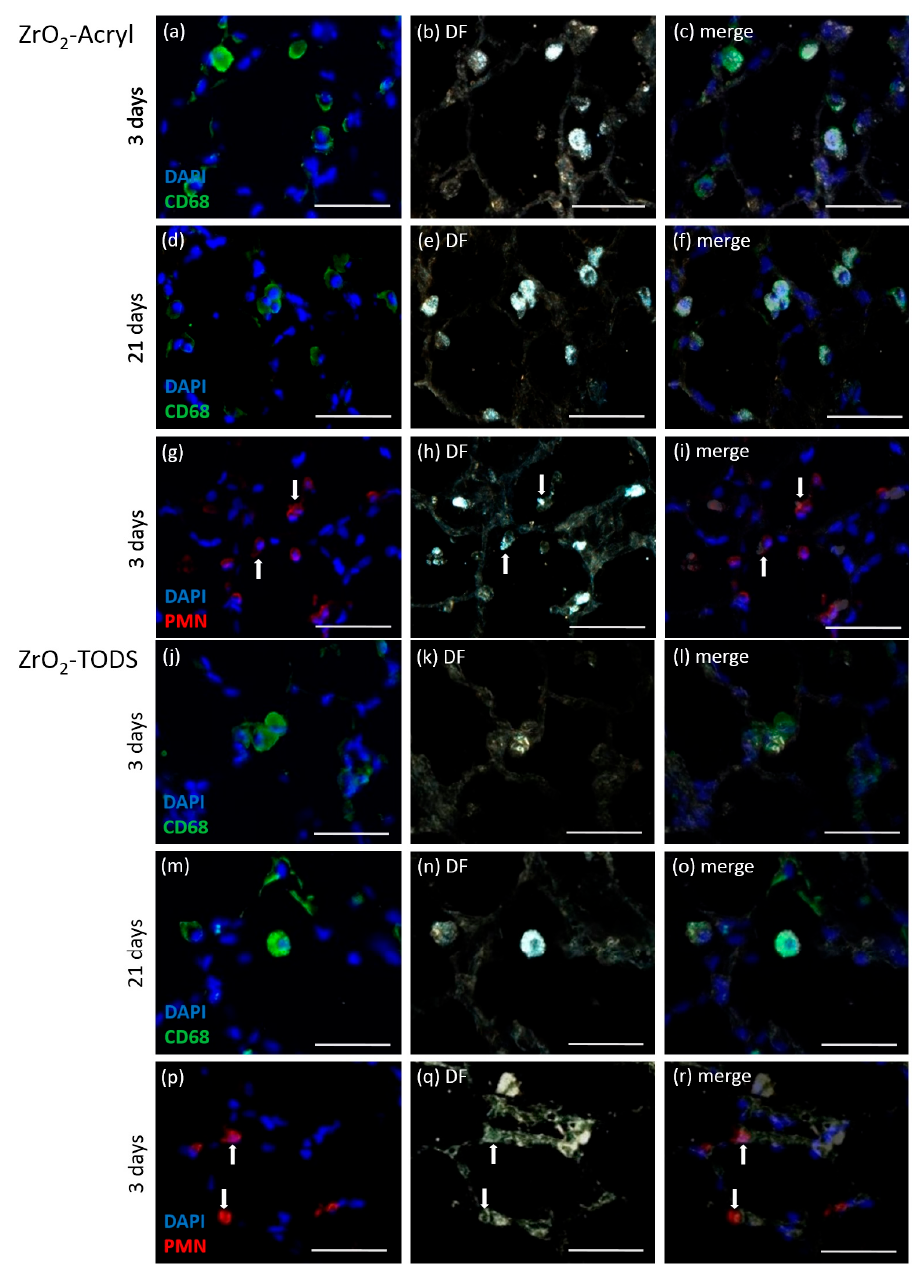
(Figure S2) were progressively collected and engulfed by alveolar macrophages and to a far lower degree by PMN, whereas no indications were found of an uptake into the lung epithelium.